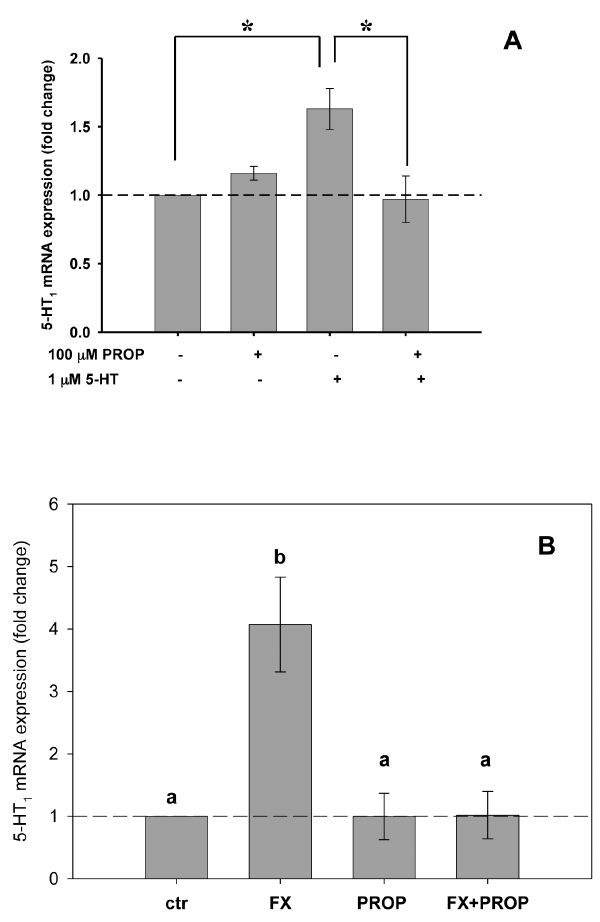
Figure 4. Relative mRNA levels of a 5-HT 1 receptor are affected by 5-HT or FX exposure. ( A ) Relative 5-HT 1 mRNA expression assessed in haemocytes incubated in vitro for 1 h with 1 m M 5-HT in the presence/absence of a 15-min pre-incubation with 100 m M PROP. Data are derived from three independent experiments (mean 6 SEM); *p , 0.05 between pairs of samples. ( B ) Relative 5-HT 1 mRNA expression evaluated in haemocytes of mussels exposed in vivo for 7 days to FX (0.3 ng/L), PROP (0.3 ng/L) or to the mixture FX + PROP (0.3 ng/ L + 0.3 ng/L). A group of control (water) exposed mussels were included in the analysis. Data are reported as mean 6 SEM. Different superscripts letters indicate statistically significant differences (p , 0.05, N=5).